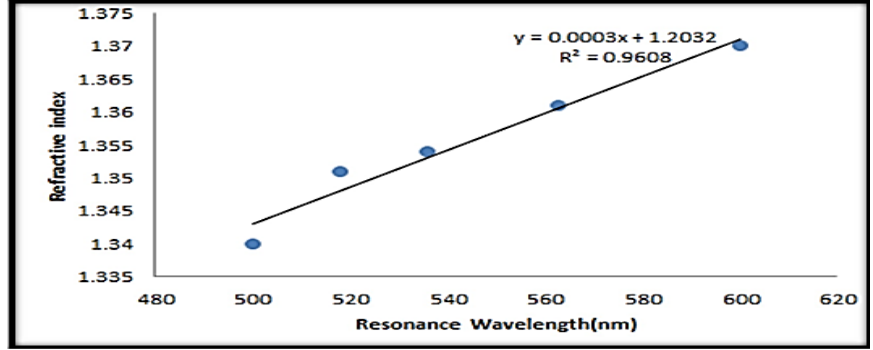
Figure 6: Refractive index in light of the wavelength of